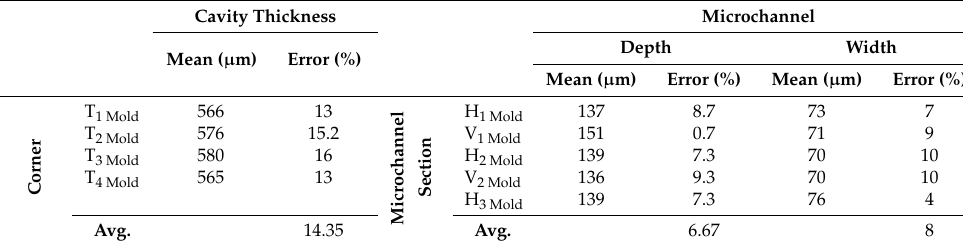
Table 1. Mold characterization